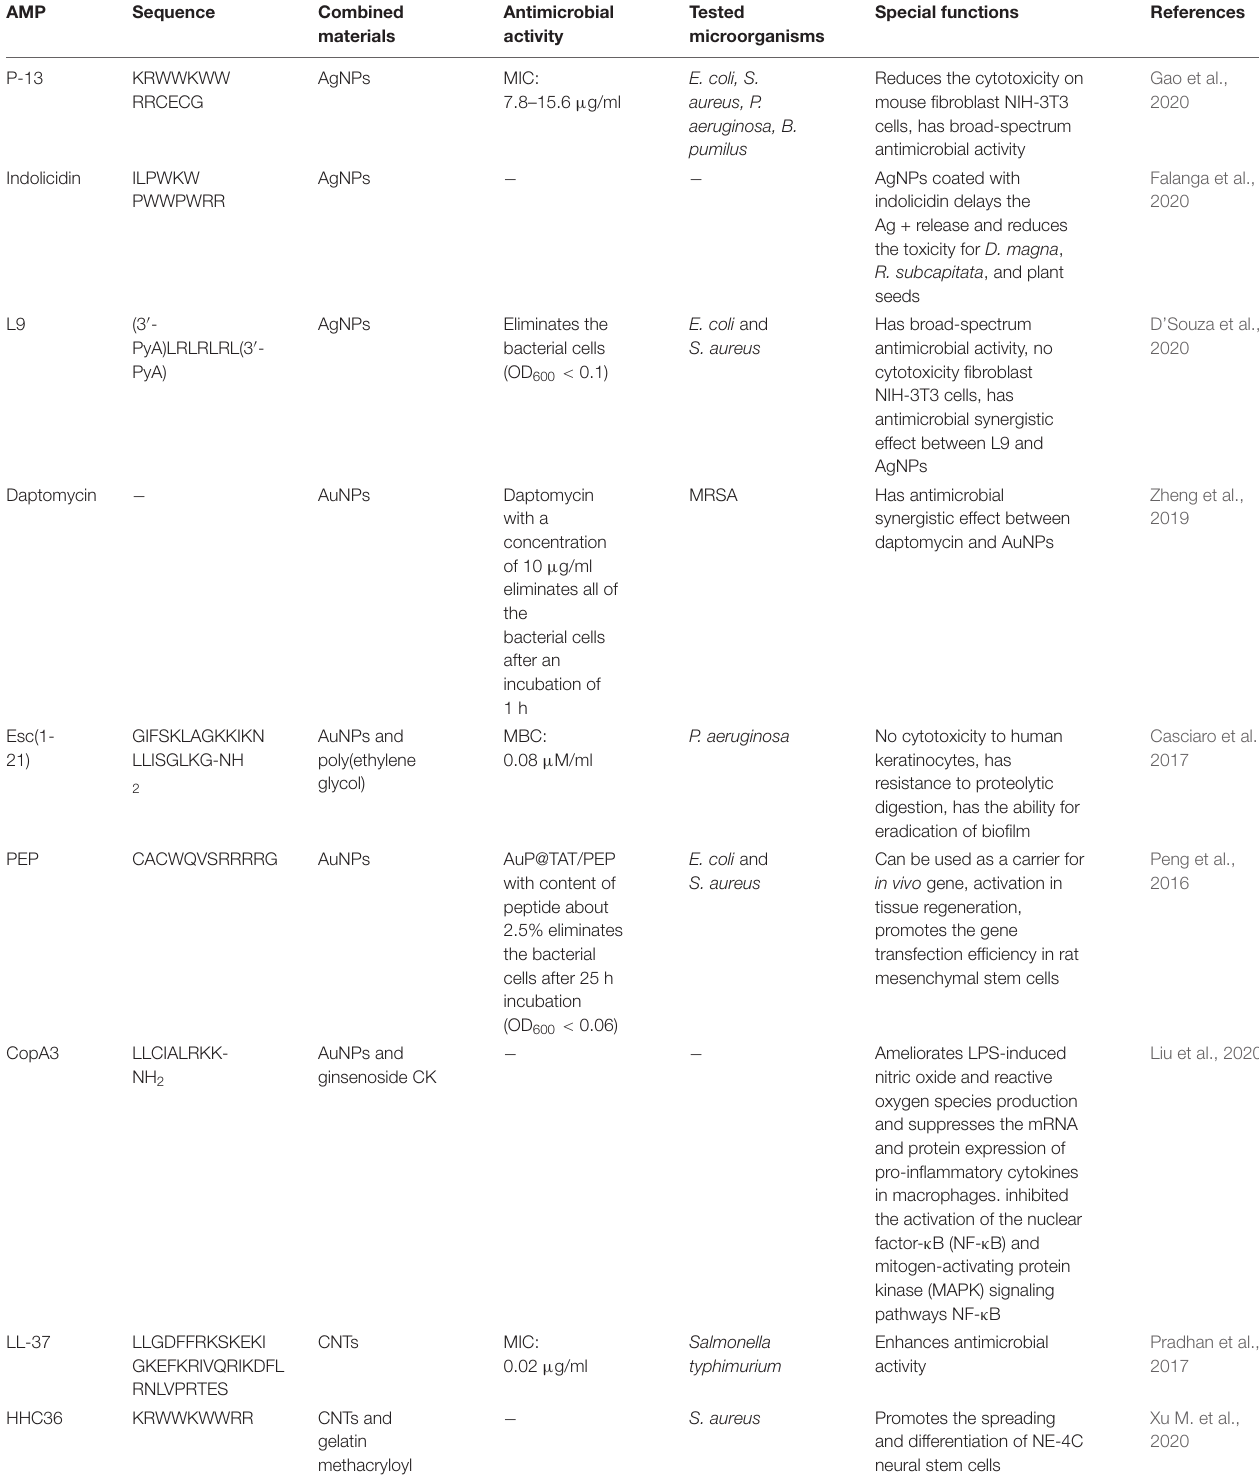
TABLE 1 | Most representative examples of inorganic material nanosystems containing antimicrobial peptides